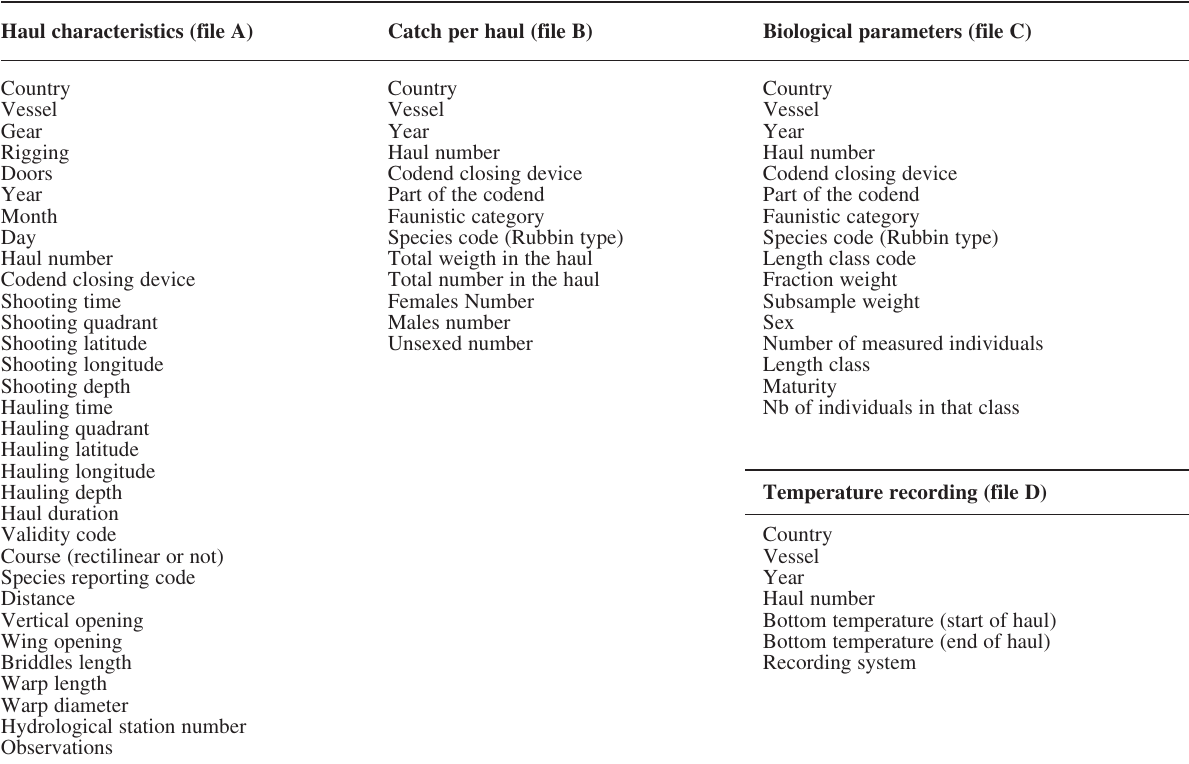
Table 5. – Parameters included in the exchange